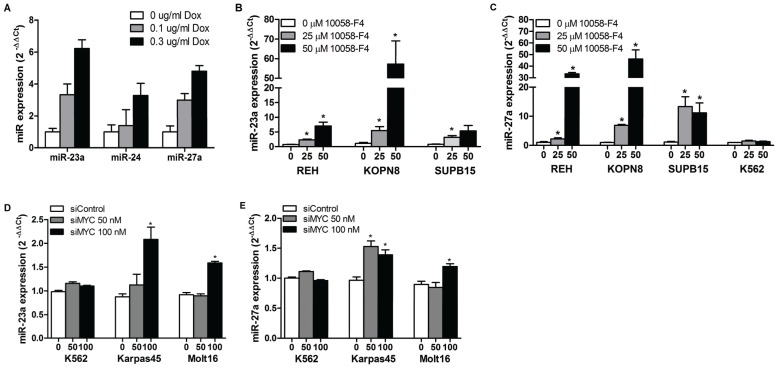
Effects of c-MYC on expression of the miR-23a cluster.(A) Knock down of c-MYC expression in P493B cells by doxycycline-treatment. Cells were treated with 0 µg/ml (white bar), 0.1 µg/ml (grey bar) or 0.3 µg/ml (black bar) doxycycline for 48 hr, harvested, and total RNA isolated. Levels of miR-23a cluster member expression were measured via qRT-PCR, using U18 as an endogenous control, and normalized to untreated (0 µg/ml Dox) cells (2−ΔΔCt = 1). (B) and (C) The effects of pharmacologic inhibition of c-MYC on miR-23a (B) and miR-27a (C) in REH, KOPN8, SUPB15, and K562 cell lines were determined by treatment with 2 doses of 10058-F4 (25 µM [grey bar] and 50 µM [black bar]) or vehicle (white bar) for 48 hr. Fold-expression of mature miR-23a and miR-27a were assessed by qRT-PCR and analyzed as above. Effect of the c-MYC inhibitor on miR-23a and miR-27a expression was determined by comparison of treated cells to the mean expression (±SEM) of vehicle-treated cells Significance was determined by a Student's t-test where p<0.05 (*) indicated significance (n = 2–6 independent experiments). (D) and (E) The effect of siRNA knock-down of endogenous c-MYC on expression of miR-23a (D) and miR-27a (E) in K562, Karpas45, and Molt16 cells were assessed by transfection with 50 nM (grey bar) or 100 nM (black bar) of an siRNA-c-MYC pool or 100 nM of control siRNA (white bar). Expression levels of miR-23a and miR-27a and significance of results were assessed as in (B) and (C). n≥3 independent experiments for all samples.